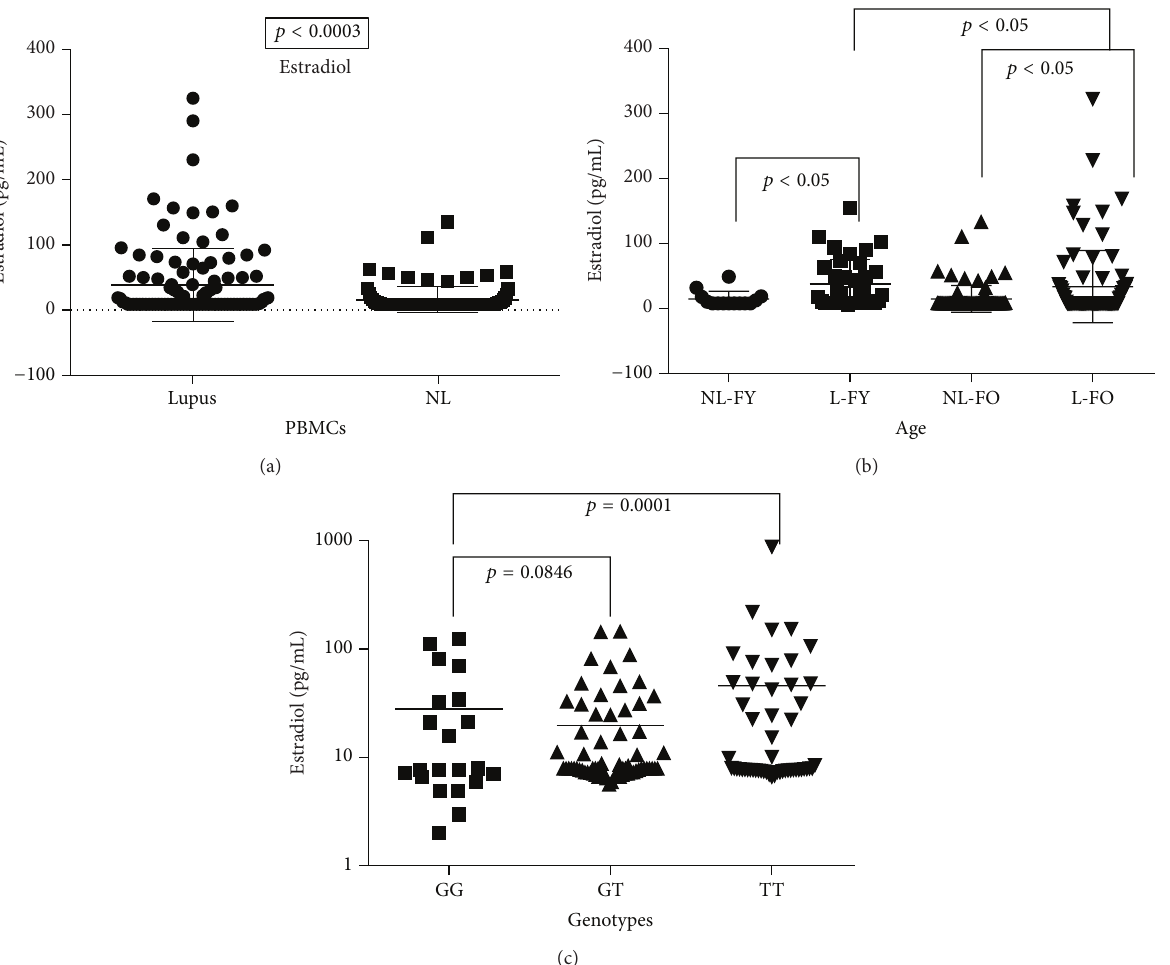
Figure 9: 17 𝛽 -estradiol levels in serum. Estradiol levels in serum were significantly higher in lupus patients (a) ( 𝑝 = 0.0003 ). (b) However, women with lupus older (FO) than 50 had higher levels compared to women less than 50 (FY). (c) Lupus patients with the TT genotype had higher levels than women with the GG genotype.